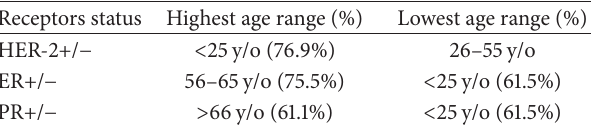
Table 2: Highest and lowest frequency of HER-2, ER, and PR status within different age